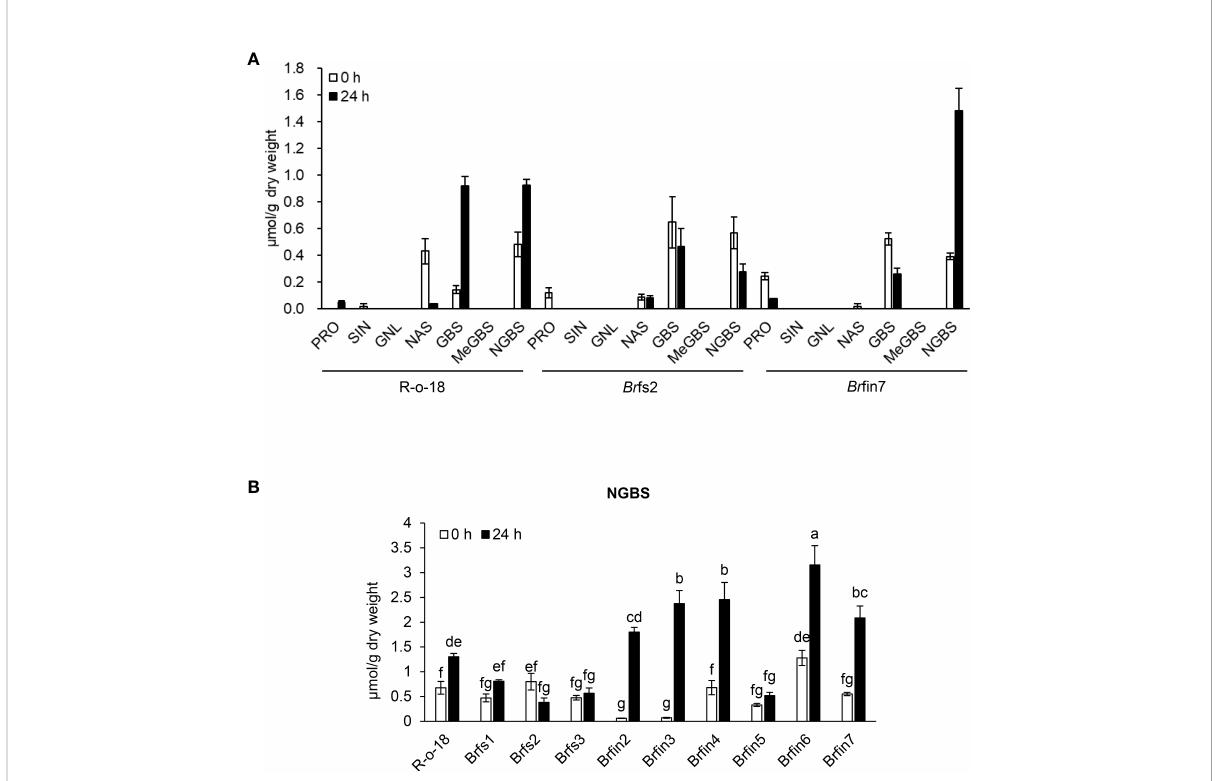
FIGURE 6 Basal or P. brasiliense -induced glucosinolate contents in B. rapa leaves. (A) Individual glucosinolate content in B. rapa before and after P. brasiliense inoculation. (B) P. brasiliense -susceptible lines Br fs1, Br fs2, and Br fs3 produced less P. brasiliense -induced NGBS than R-o-18. Individual leaf glucosinolate contents were quanti fi ed before the inoculation and at 24 h post-infection. Pro, progoitrin; SIN, sinigrin; GNL, gluconapoleiferin; NAS, gluconasturtiin; GBS, glucobrassicin; MeGBS, 4-methoxyglucobrassicin; NGBS, neoglucobrassicin. Error bars represent standard deviations of three replications. Different letters indicate signi fi cant differences among plant genotypes ( a = 0.05, one-way ANOVA and Tukey HSD test; SPSS